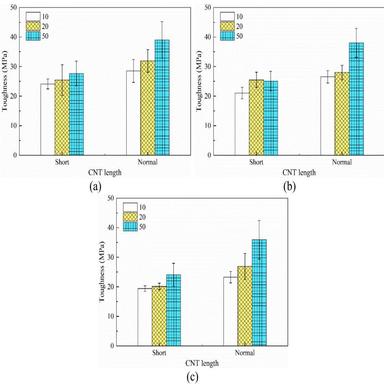
Toughness of CNT reinforced epoxy composites with different CNT geometries: (a) 0.5%; (b) 1%; (c) 2% CNT fractions.